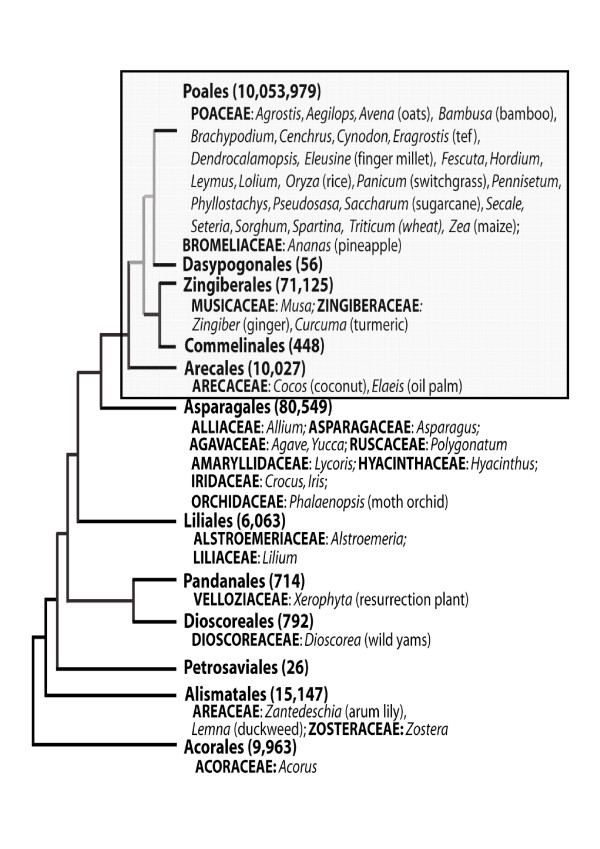
Current understanding of relationships among monocot orders [118]. Families are shown in bold caps and genera with EST sequences in dbEST [119]. The number of sequences in GenBank (as of 10/08/07) are shown in parentheses for each order and the shaded box highlights Commelinid orders. The nodes with < 75% bootstrap support are grey.